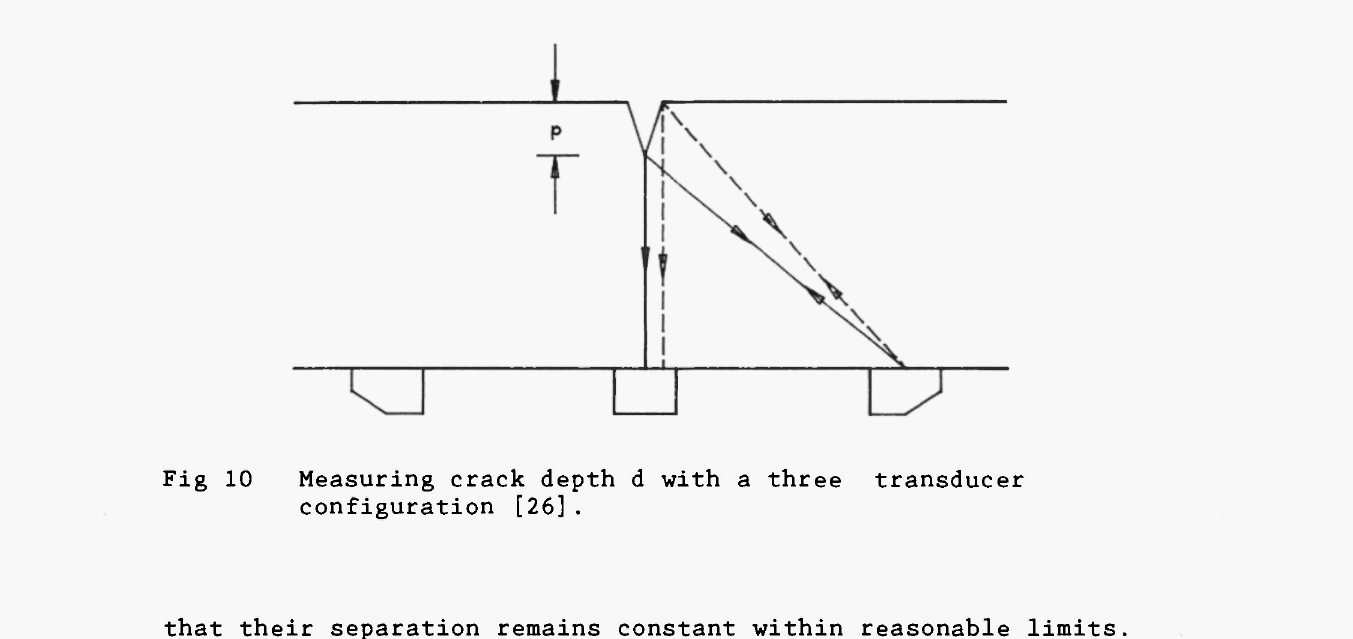
that their separation remains constant within reasonable limits. In some applications like crack sizing in T-butt welds, the physically linked probes provide a serious drawback. Silk of